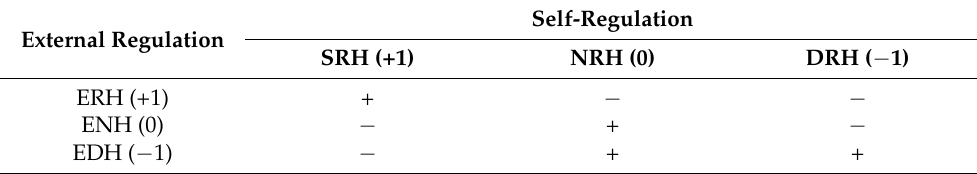
Table 3. Types of self and external regulation of